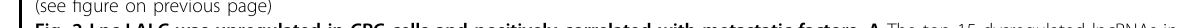
detected the expression of the 4 lncRNAs in the 40 sam- ples by qRT-PCR assay and found that only LINC00922 was positively correlated with CRLM and negatively cor- related with LZTS1 expression ( r = − 0.6213, P < 0.0001) (Fig. 2E, F); The expression pattern in CRC cell lines were